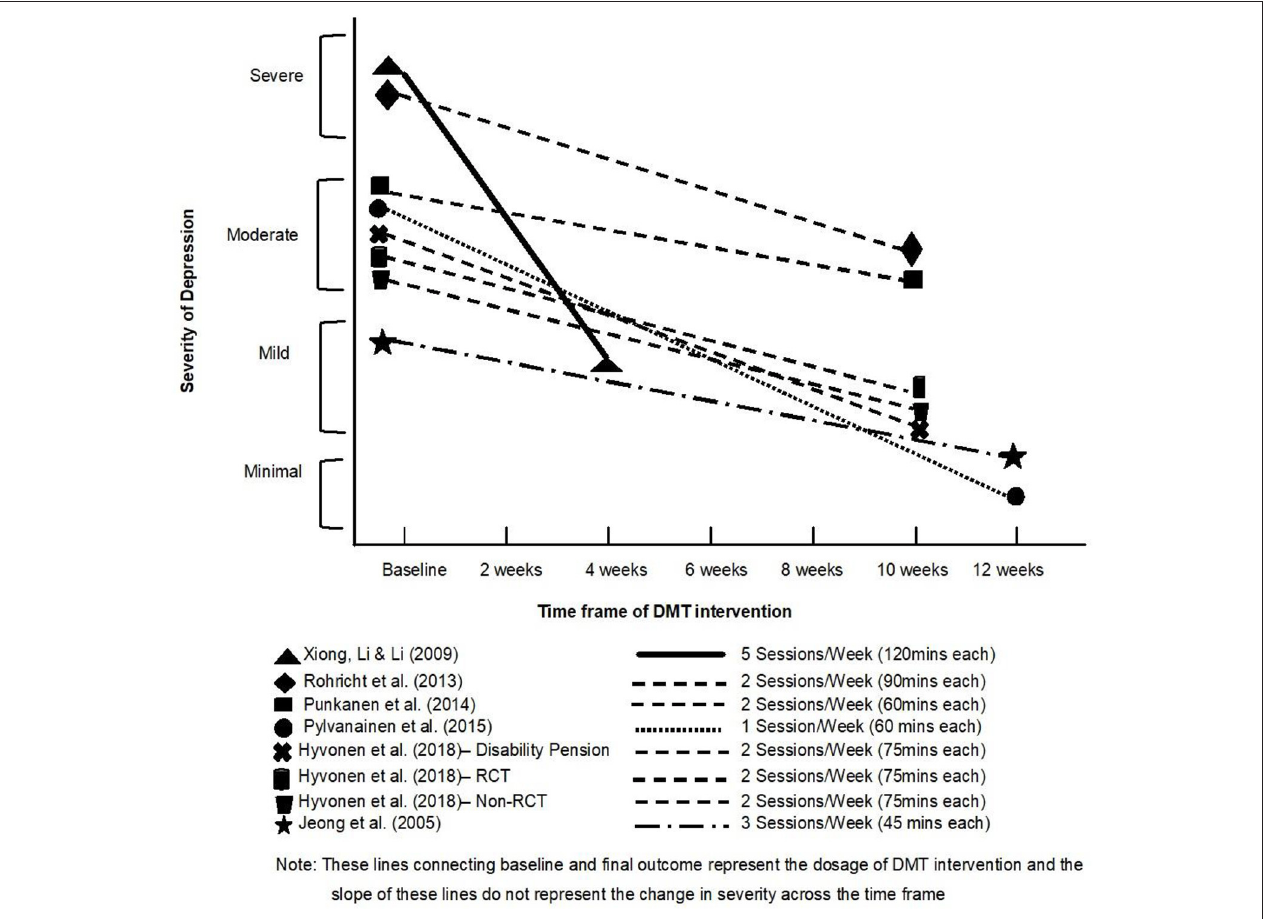
FIGURE 3 | Depression outcome scores before and after DMT